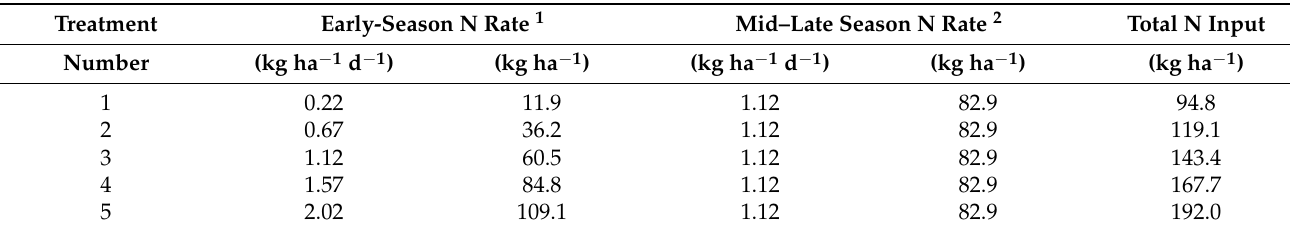
Table 2. Nitrogen (N) fertilization treatments tested for ‘Florida Radiance’ and ‘Florida127’ strawberry in the 2014–2015 growing season.